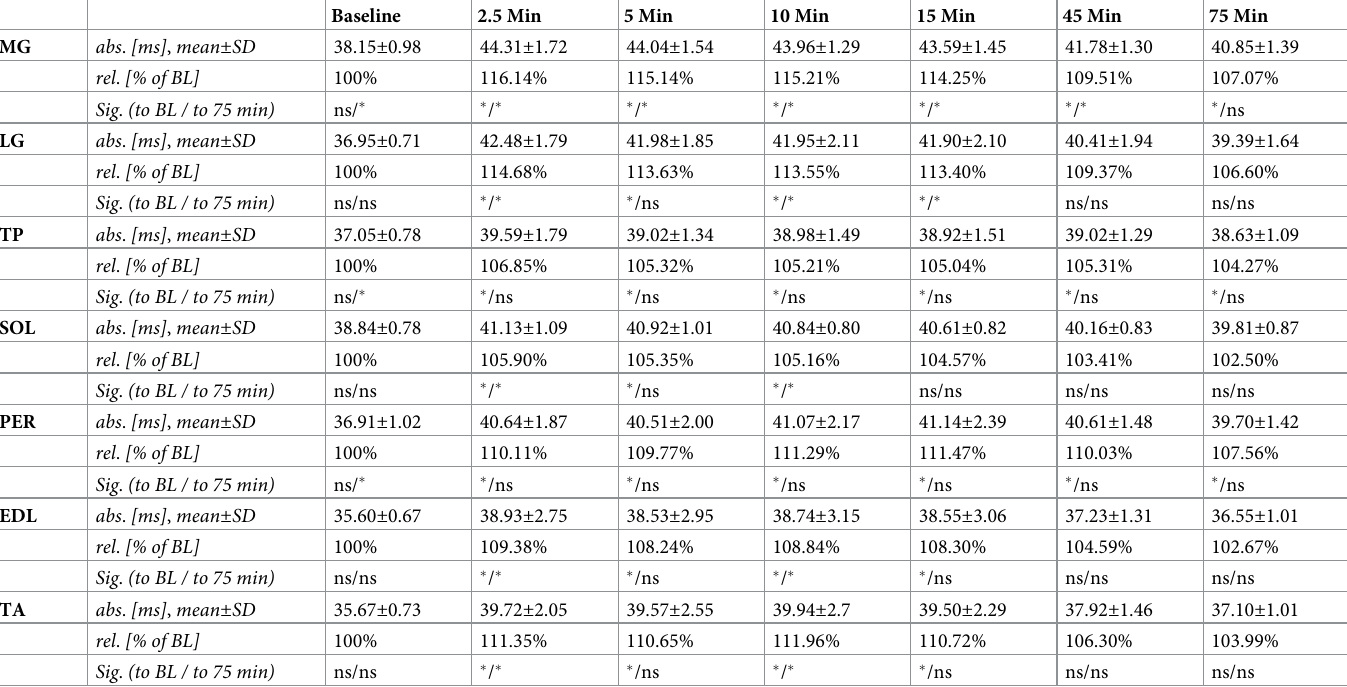
Table 2. Absolute and relative changes of the T2 relaxation times during prolonged running.